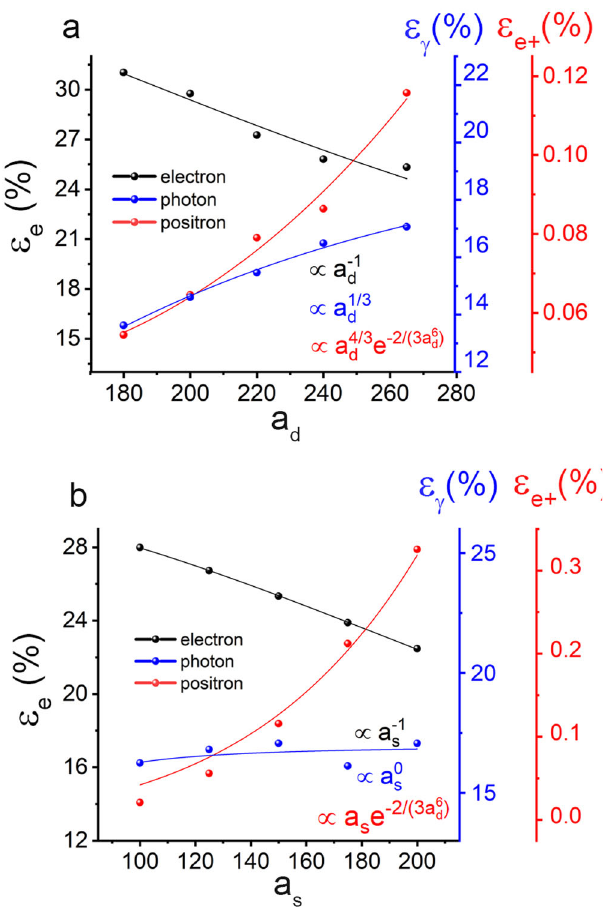
Fig. 7 Laser energy conversion ef fi ciency to electrons, γ -photons and positrons. Energy conversion ef fi ciency ( a ) with different a d and a fi xed a s ; ( b ) with different a s and a fi xed a d